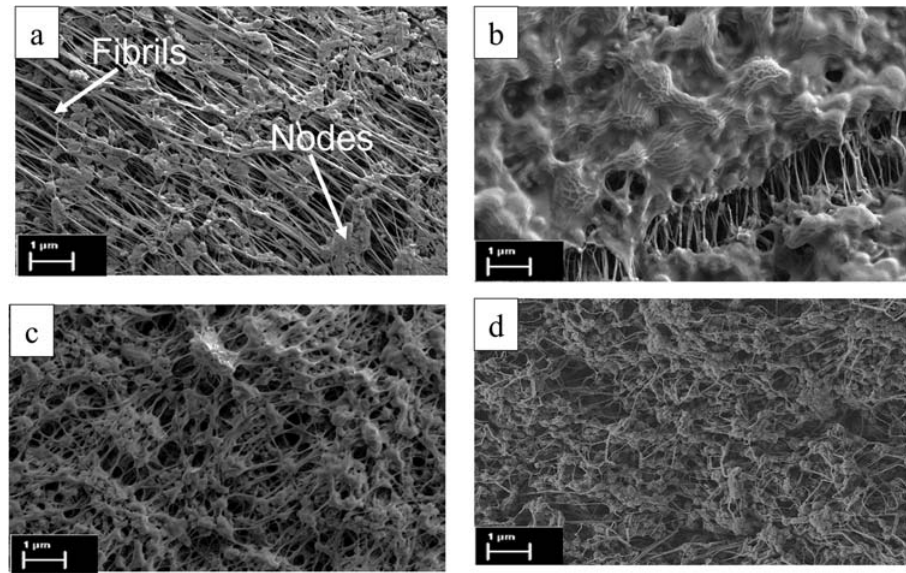
Figure 3: Morphology of ( a ) unmodi fi ed ePTFE, ( b ) sample AH, ( c ) sample AN, and ( d ) sample